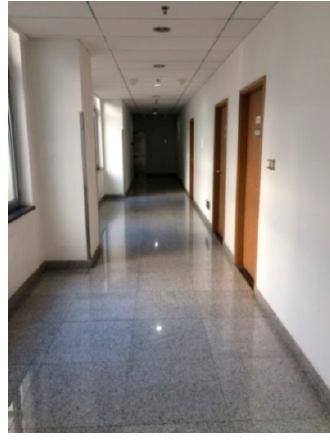
Figure 8. Test environment.